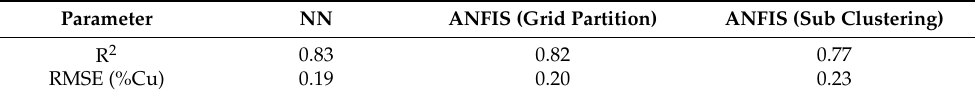
Table 1. Correlation coefficients and RMS errors between the actual and predicted values of Cu % for the NN and ANFIS models.